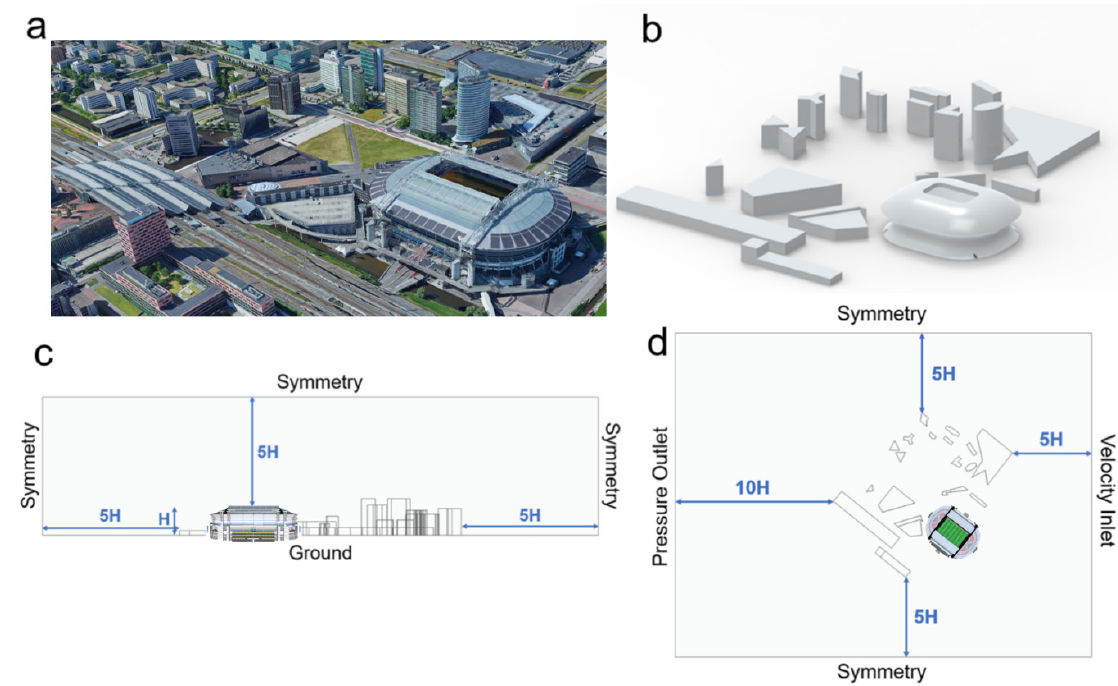
Figure 1. ( a ) Semi-enclosed stadium with neighboring buildings within 300 m from the stadium. ( b ) Three-dimensional CAD geometry model of the stadium. ( c ) Vertical cross-section view of the computational domain. ( d ) Horizontal cross-section view of the computational domain.